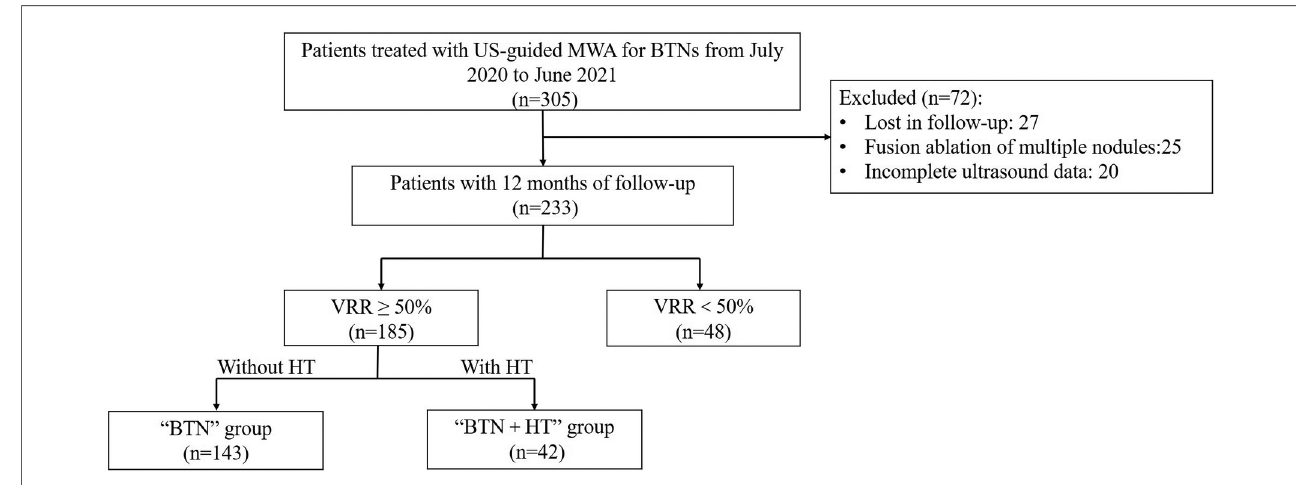
FIGURE 1 Flow chart of patient selection for this study. BTN: benign thyroid nodule; HT, Hashimoto ’ s thyroiditis; VRR, volume reduction ratio; MWA, microwave